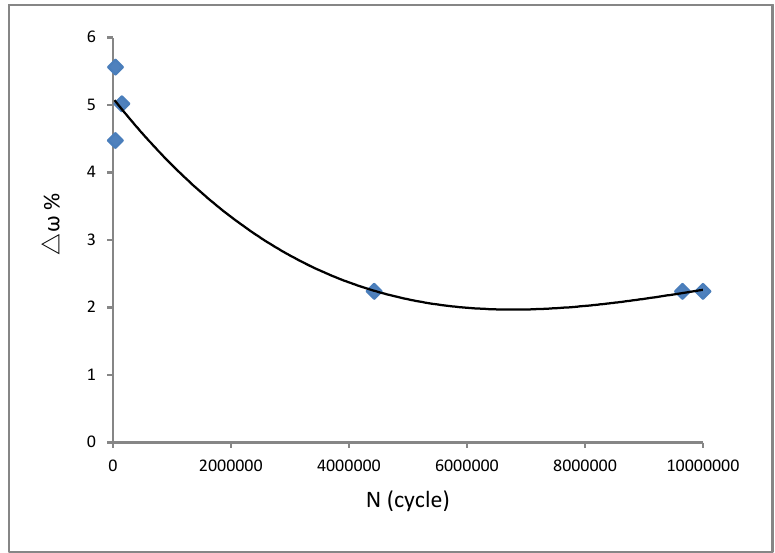
Figure 10. Frequency reduction for vibration fatigue experimental end criteria.